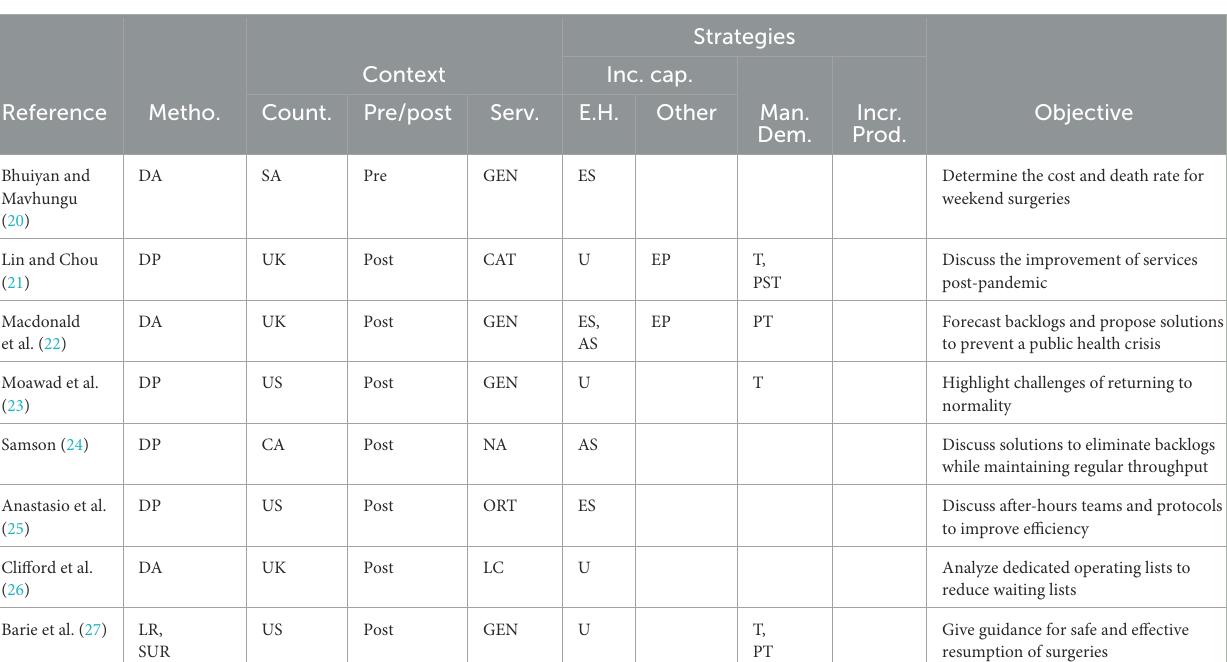
TABLE 2 Resulting papers concerning extended hours in surgical